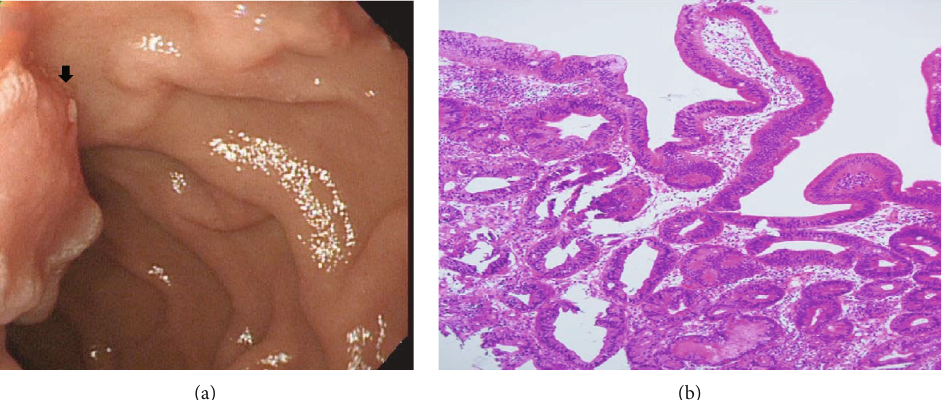
Figure 2: (a) Flat periampullary Vater tumor (arrow). (b) Duodenal tubular adenoma with mild dysplasia composed of dysplastic glandular cells with low-grade dysplasia in tubular architecture (H&E, 100x).